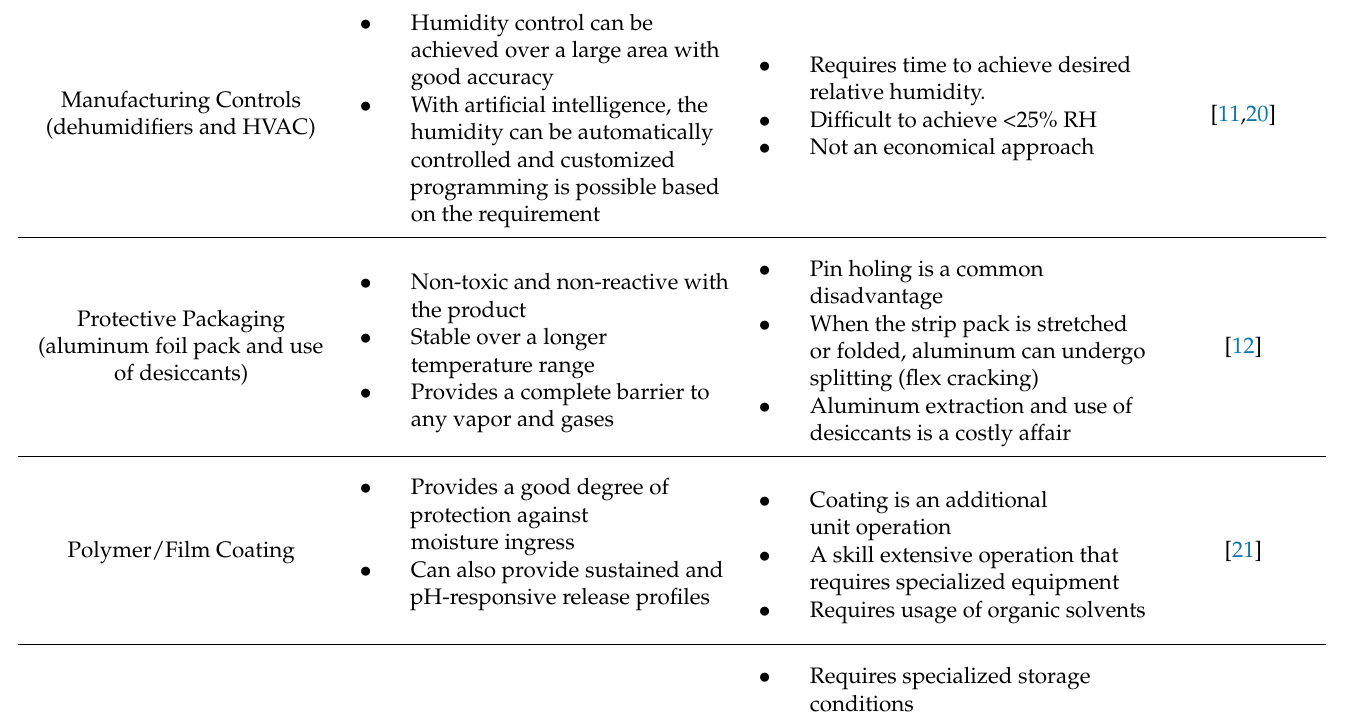
Table 1. Advantages and disadvantages of various approaches to control the hygroscopicity issues of API. Control